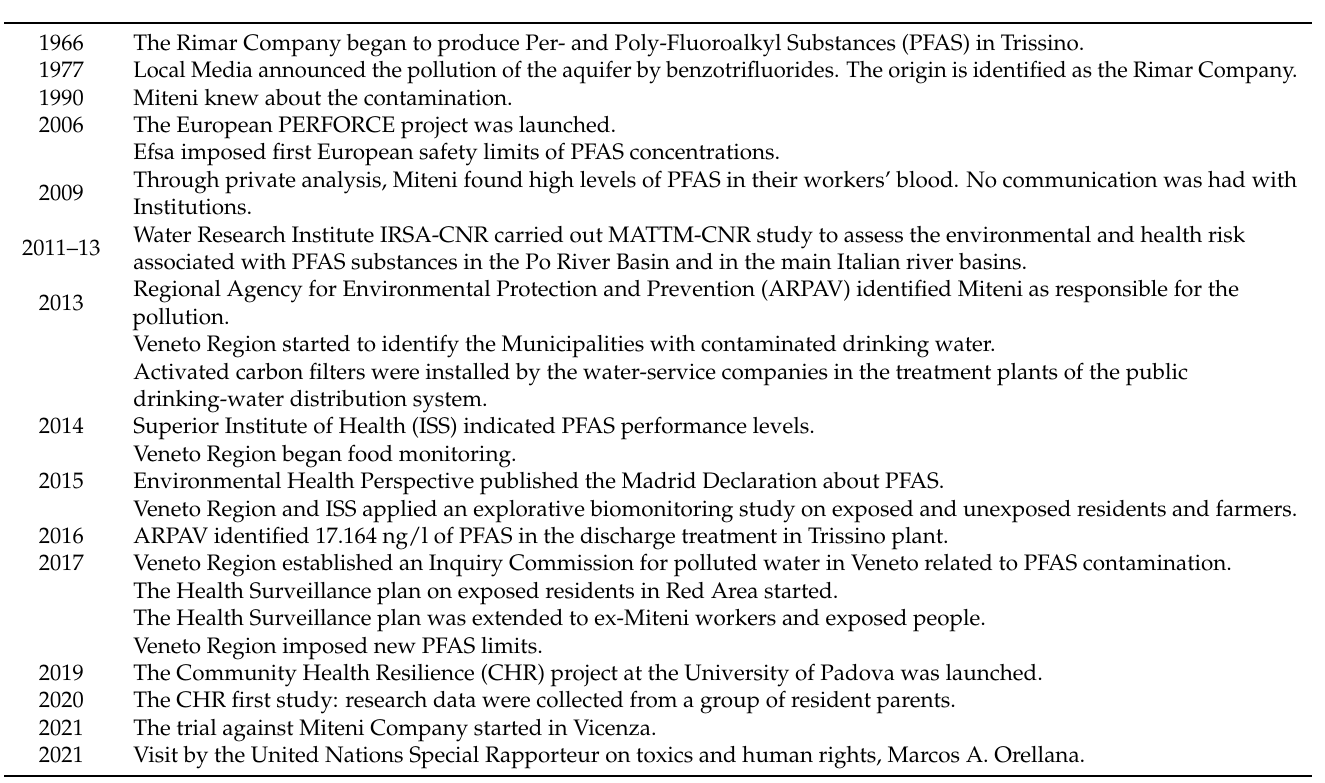
Table 1. Timeline of PFAS contamination in the Veneto